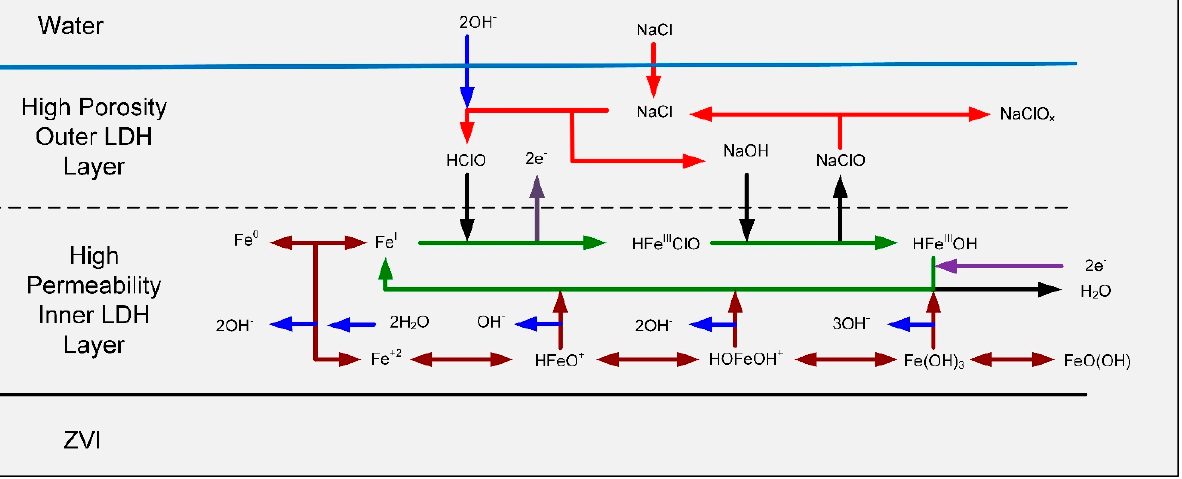
6.16 Figure 9. Desalination. ( a ) Desalination vs. trial number. ( b ) Desalination vs. feed water